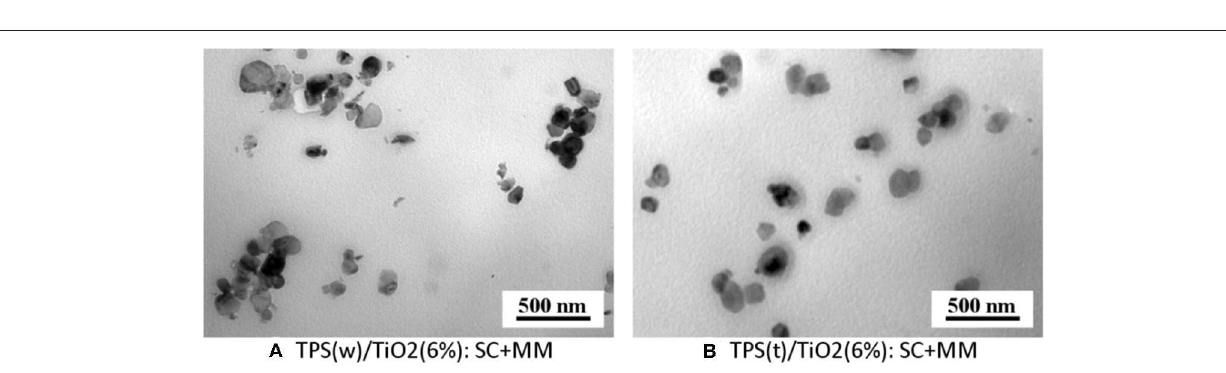
amorphous part of TPS(t) matrix. It can be seen in the spectra that the addition of TiNT resulted in a much stronger interaction and matrix destruction which is supported by a new band at 1,057 cm − 1 and a decrease of the band around 1,080 cm − 1 (C-O-H bending). On the other hand, in wheat composites [TPS(w)/TiX], the interactions between TiX fillers and the matrix were negligible. The addition of TiO 2 seemed to increase the crystallinity of the composites, while TiNT had no clear effect on the